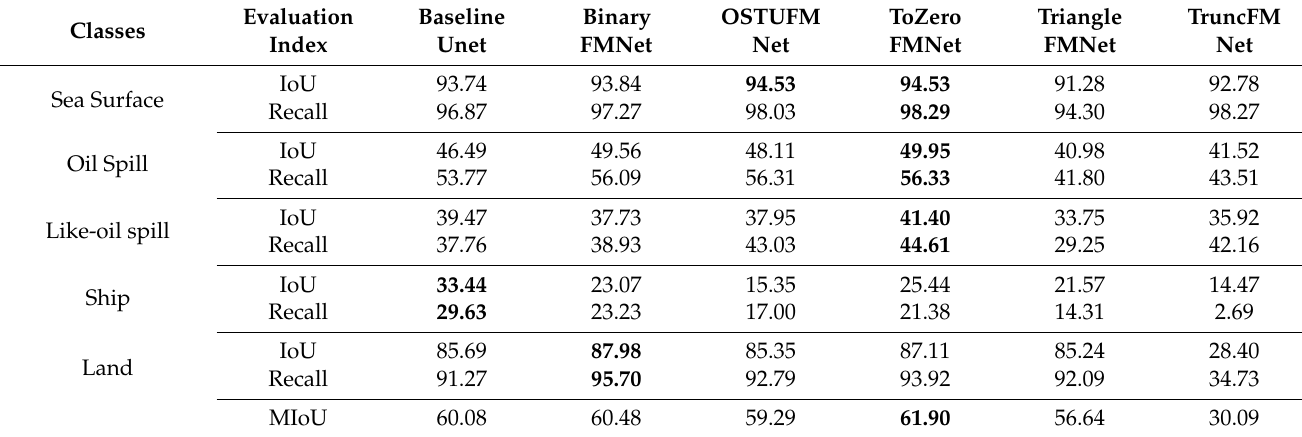
Table 2. Comparison between Baseline_UNet and five FMNets in terms of intersection-over-union or IoU (%). N.B. the bold text indicates the best